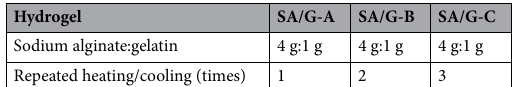
Cell extraction and culture.